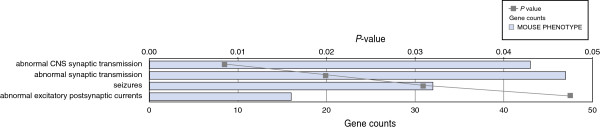
Mouse phenotype categories associated with differentially expressed genes in the En2-/-hippocampus. Differentially expressed genes in En2-/- hippocampus were analyzed for enrichment in mouse phenotypes using ToppGene with a corrected P value cutoff of 0.05. Categories are arranged from most significant and downwards (gray line); number of genes in the category is indicated by the length of the horizontal bars (gene counts).